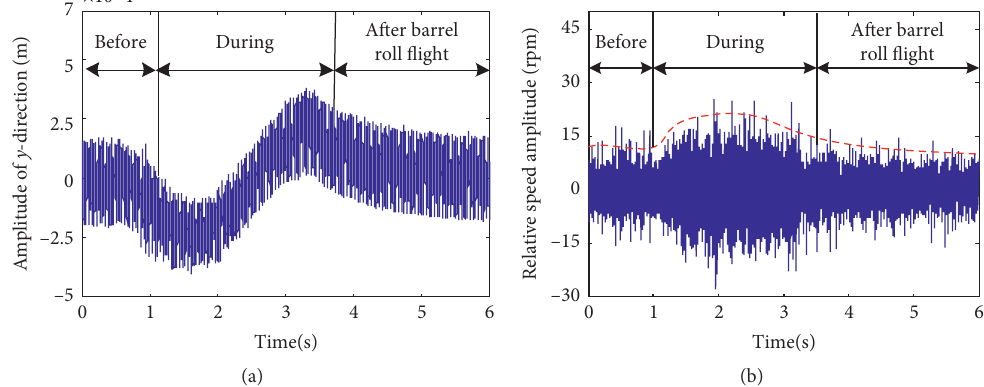
Figure 20: Transient time history of the bending and torsional motions of the rotor test fig during the flight of the base motion platform ( t ∈ [ 0s , 6 s ]) . (a) Bending motion and (b) torsional motion.